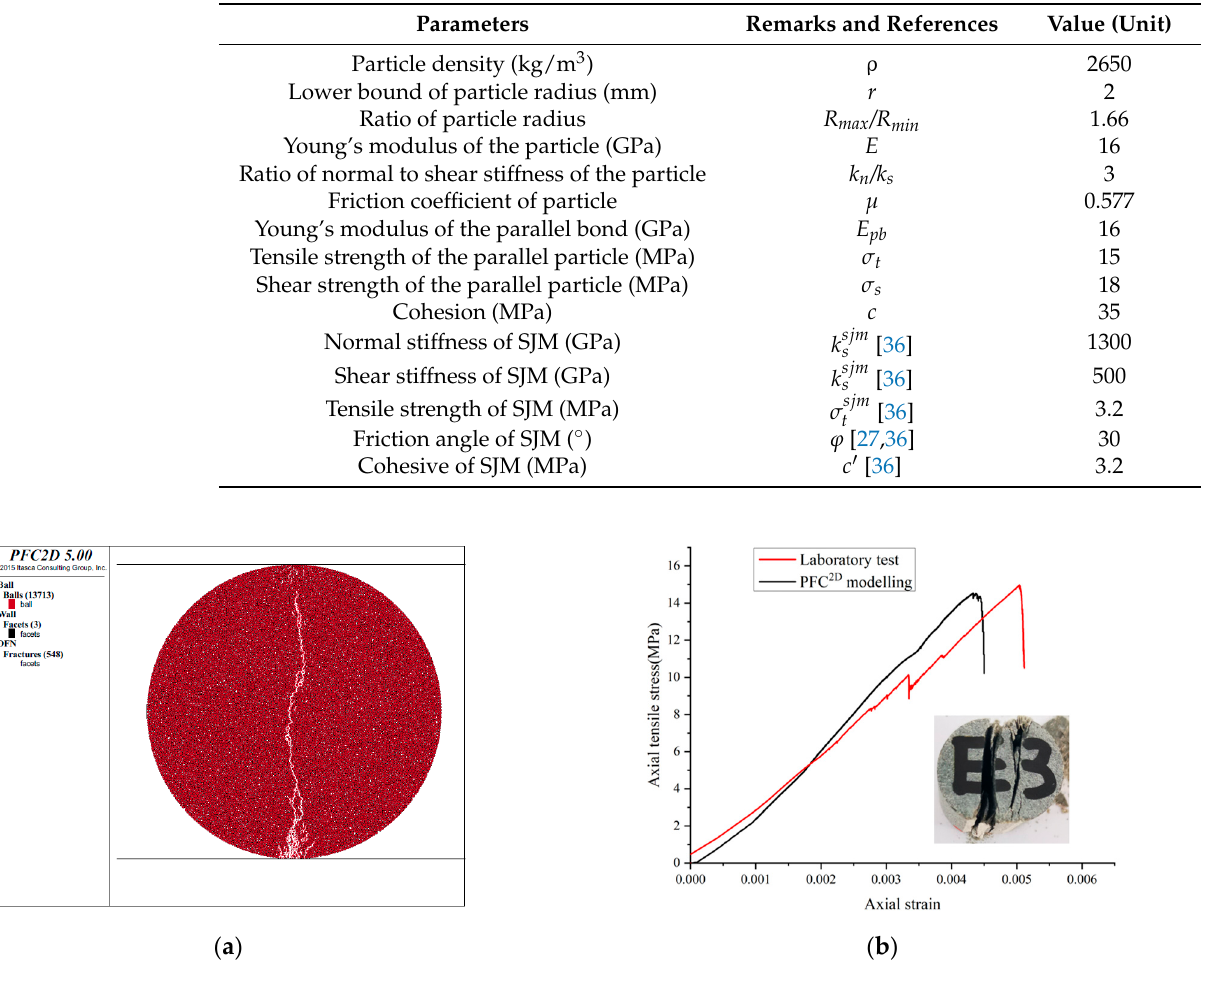
Figure 3. Calibration of the contact model to the laboratory specimen under Brazil test: ( a ) numerical simulation of tensile test; ( b ) comparison of experimental results with numerical simulation results. Table 2. Calibrated microscopic properties of the sandstone model.